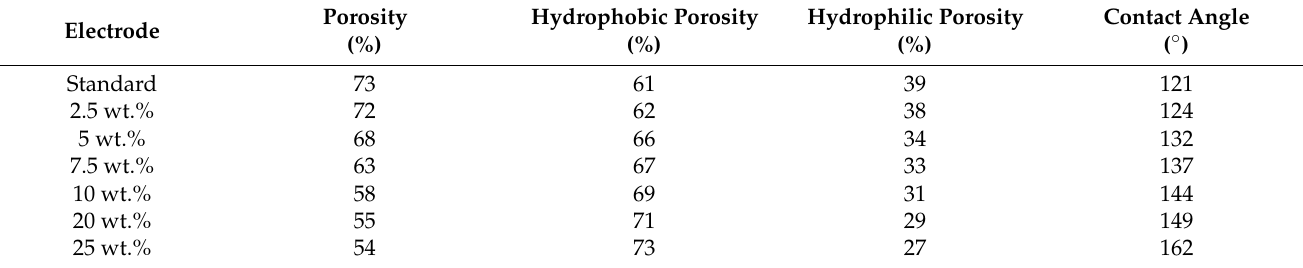
Table 1. Porosity, hydrophobic, hydrophilic porosity and contact angle values of standard and different graphene wt.%